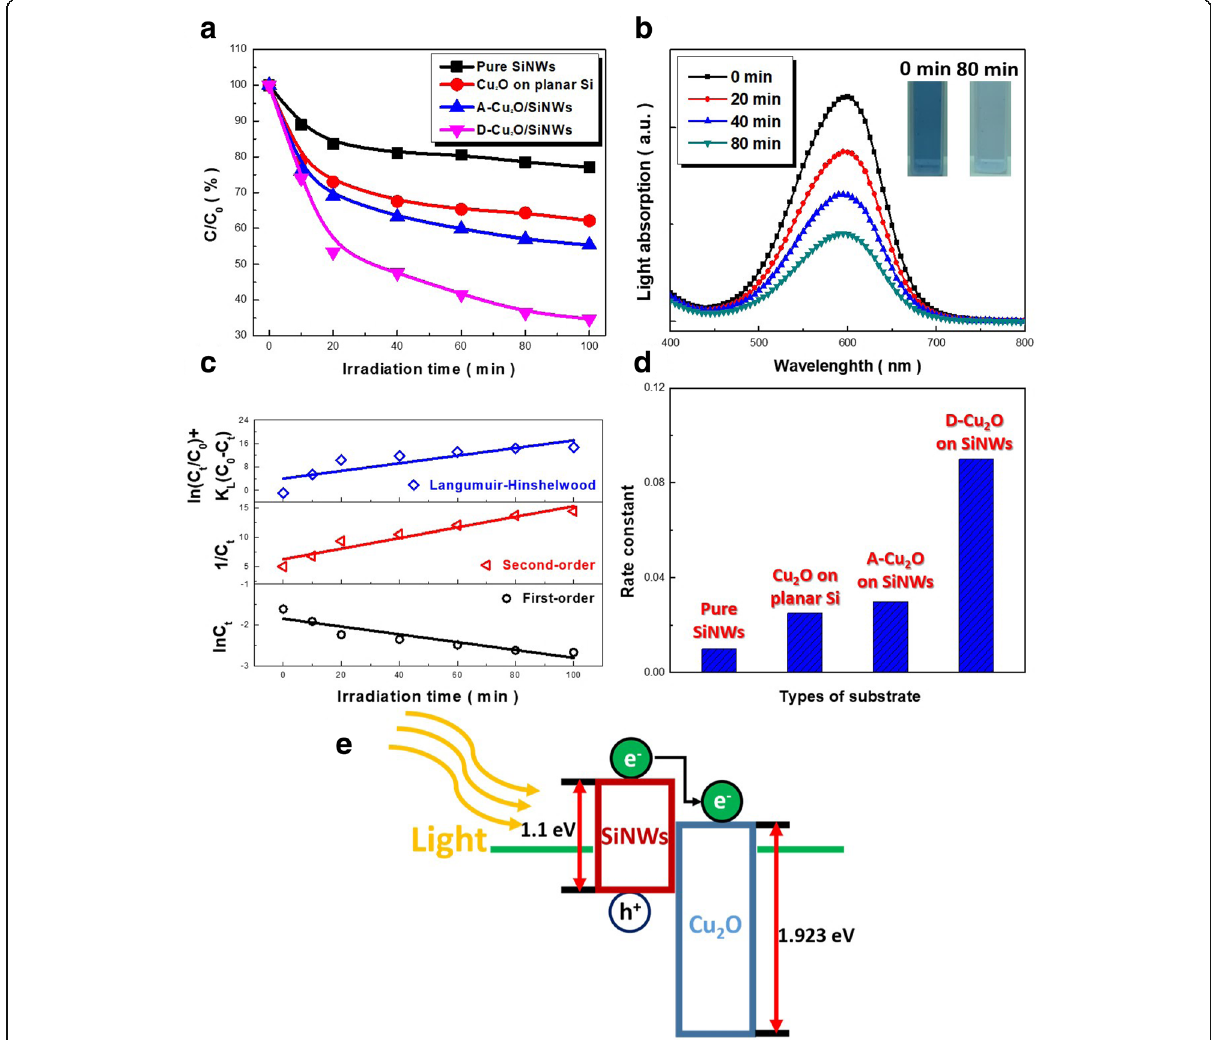
Fig. 4 a Photocatalytic tests of four various photocatalysts. b Changes of absorption spectra and c the correlated kinetic modeling in the presence of D-Cu 2 O/SiNW arrays at various durations of light illuminations. The insert figure in b presented the color change of dye solutions from 0 to 80 min. d Comparisons of rate constants of photodegradation. e Band diagram of Cu 2 O/SiNW